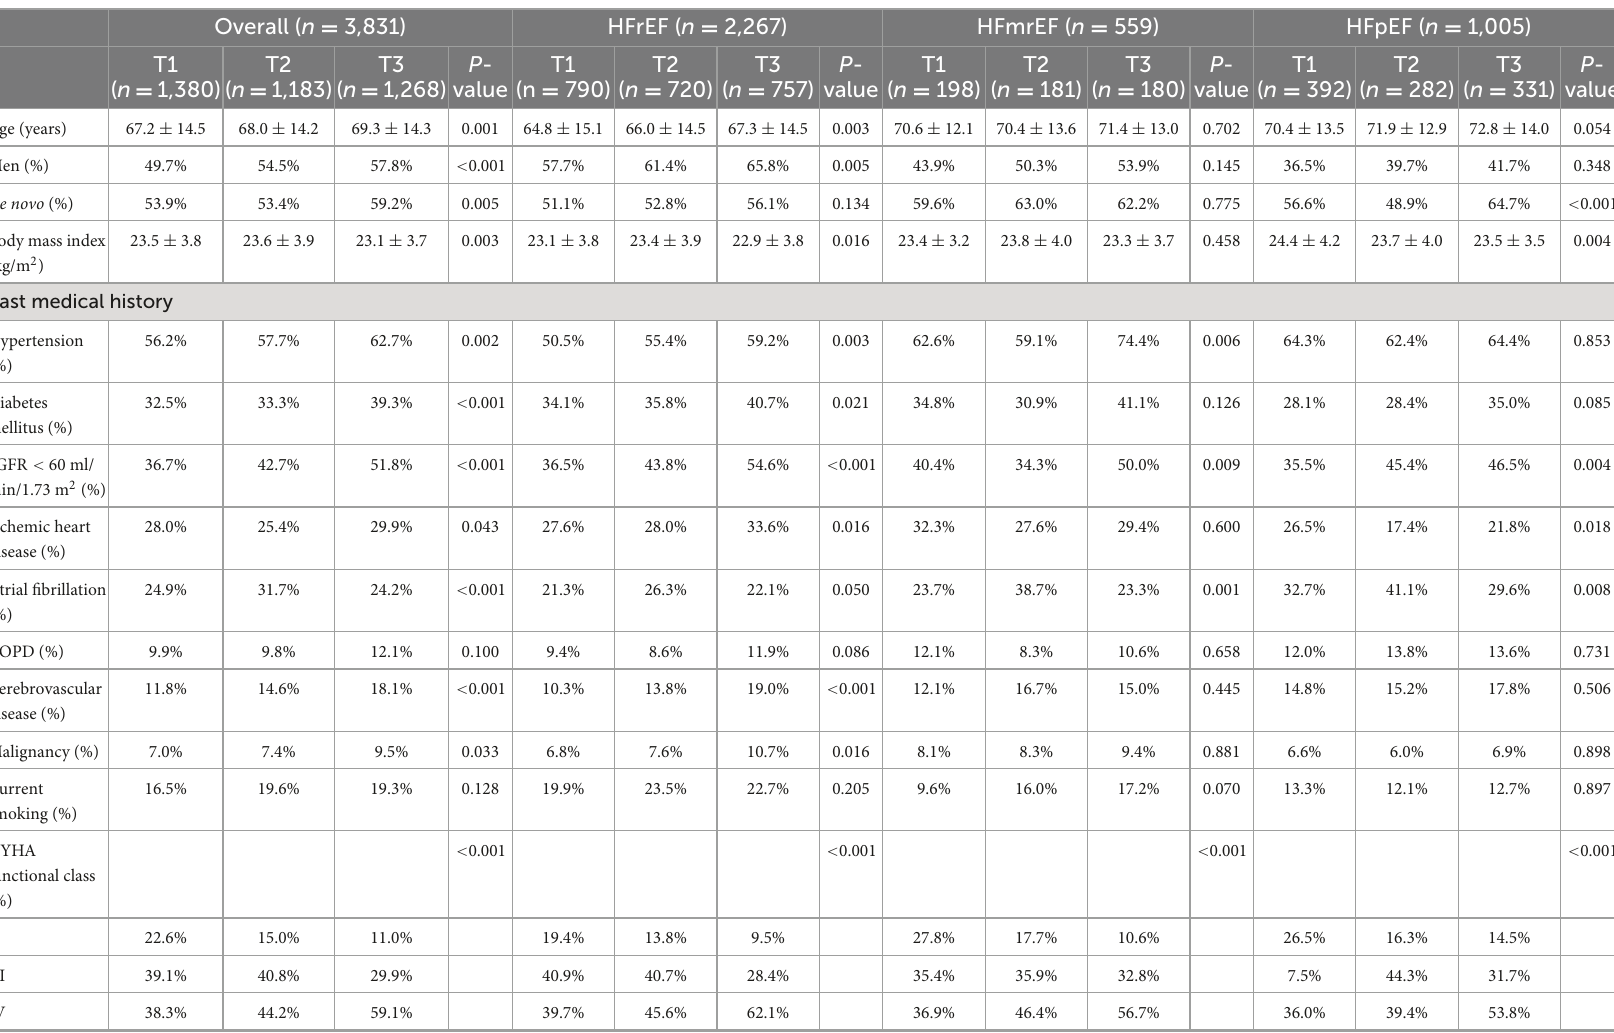
TABLE 1 Baseline characteristics of the study population according to the heart failure (HF) categories and tertiles of C-reactive protein (CRP)